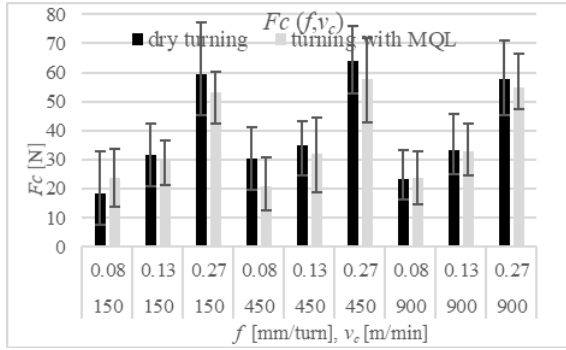
Figure 18. Cutting force Fc in aluminium composite turning with polycrystalline diamond tool